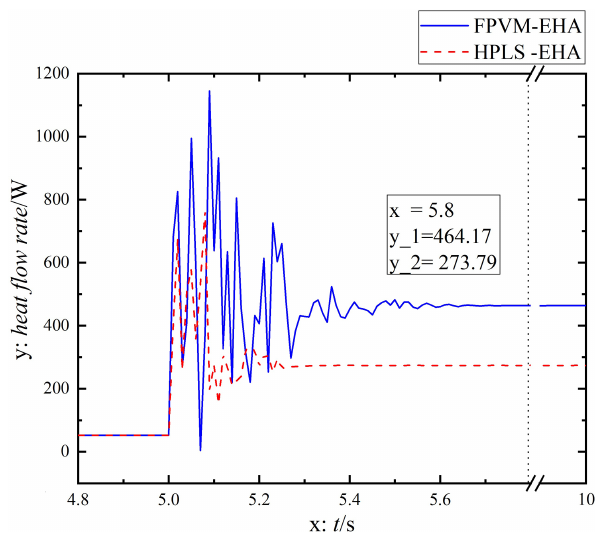
Figure 9. Contrast diagram of heat flow rate of motor.